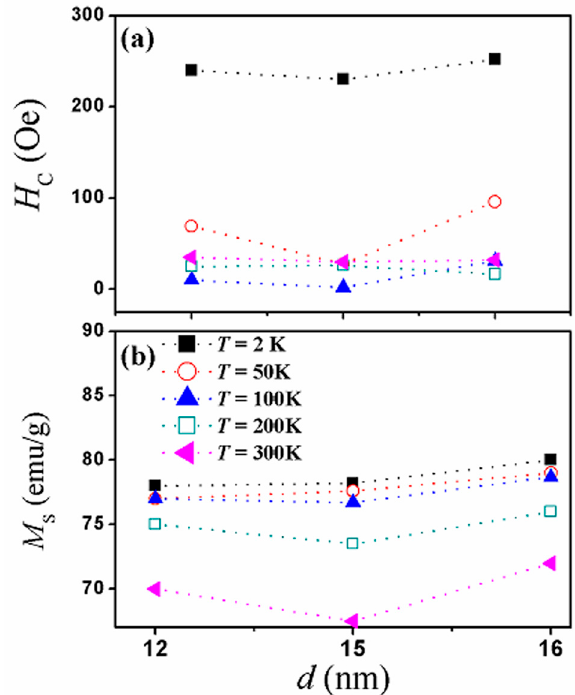
Figure 11. ( a ) Saturation magnetization and ( b ) coercivity as a function of the particle diameter at several temperatures.